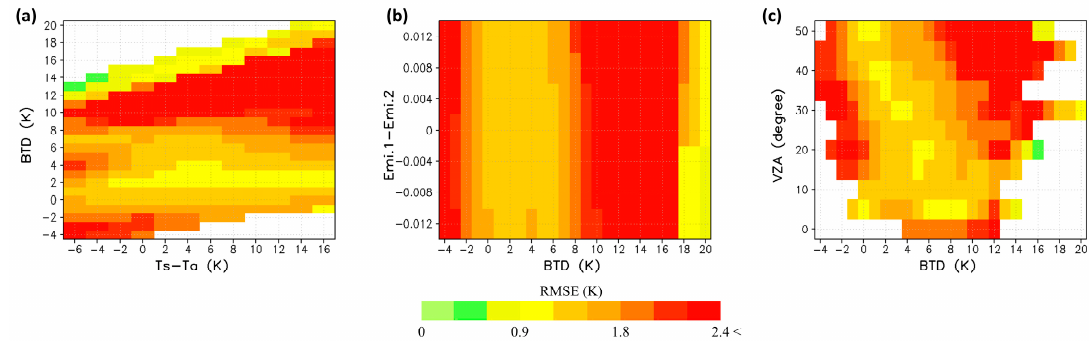
Figure 4. Distribution of RMSEs between LST calculated from radiative transfer model simulated brightness temperature and prescribed LST according to different impacting factors: ( a ) brightness temperature difference (BTD) and surface lapse rate, ( b ) emissivity difference and BTD, ( c ) satellite viewing zenith angle (VZA) and BTD.